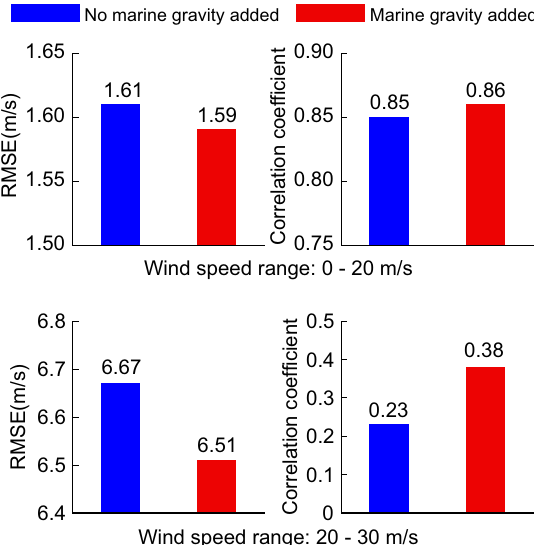
Fig. 5 The CYGNSS wind speed retrieval performance before and after the addition of marine